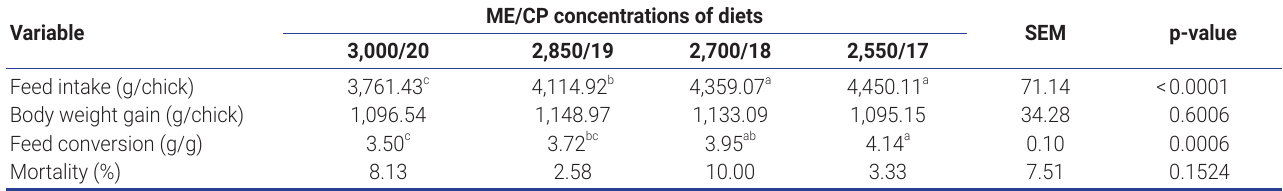
Table 2. Cumulative productive performance of Mexican Creole chickens from hatching to 12 weeks of age fed diets with different concentra- tions of ME and CP Variable